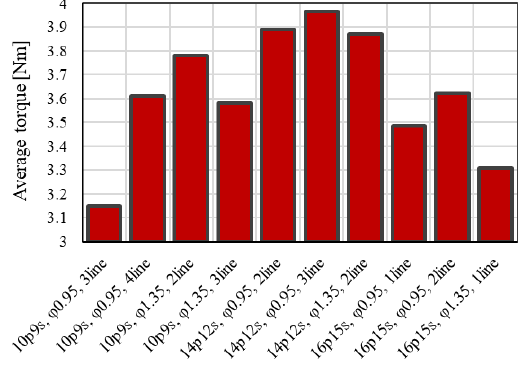
Figure 16. Average torque in each model.